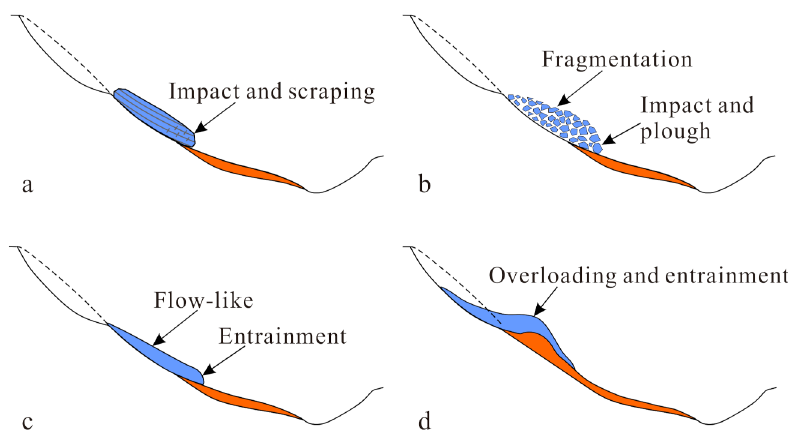
Figure 16. The typical entrainment modes. ( a ). Intact impact and scraping. ( b ). Fragmented impact and plough. ( c ). Flow-like entrainment. ( d ) Overloading and